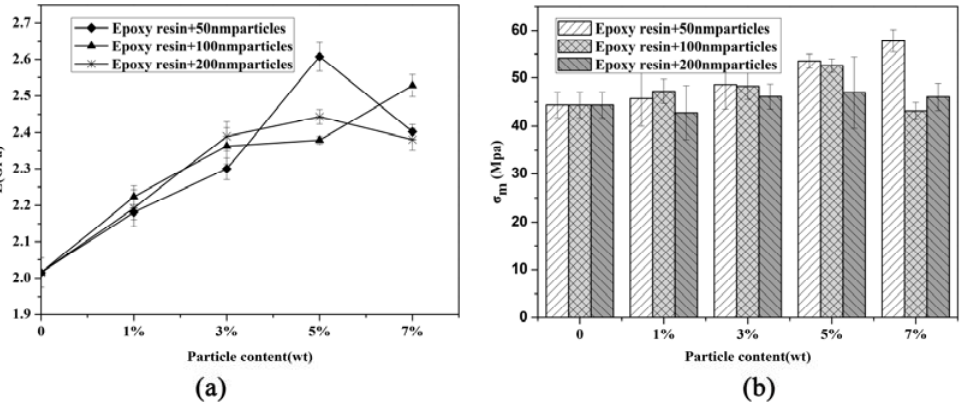
Figure 8. Tensile modulus and strength of epoxy modified with nano ‐ Al 2 O 3 : ( a ) tensile modulus (E), ( b ) tensile strength ( σ m ).